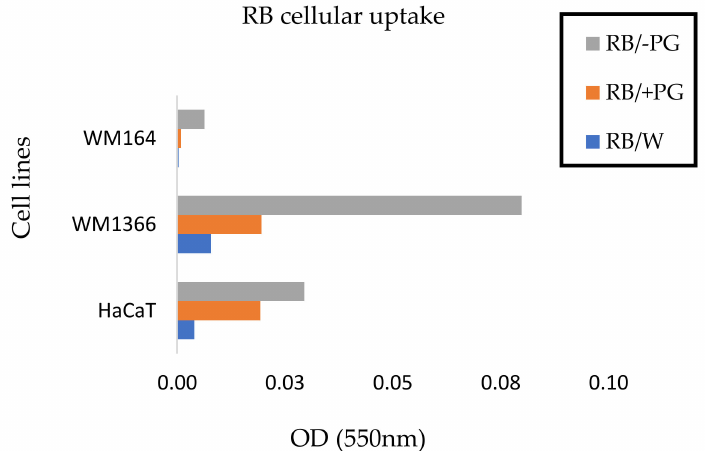
Figure 6. Optical density of lysates. Optical density of lysates from Melanoma (WM164 and WM1366) and normal keratinocyte (HaCaT) cells treated for 24 h with final concentrations of 50 µ M RB incorporated in water, SEME–PG, and SEME + PG. RB uptake is normalized against untreated control cells. Incubation with RB incorporated in SEME–PG showed higher cellular uptake of the active